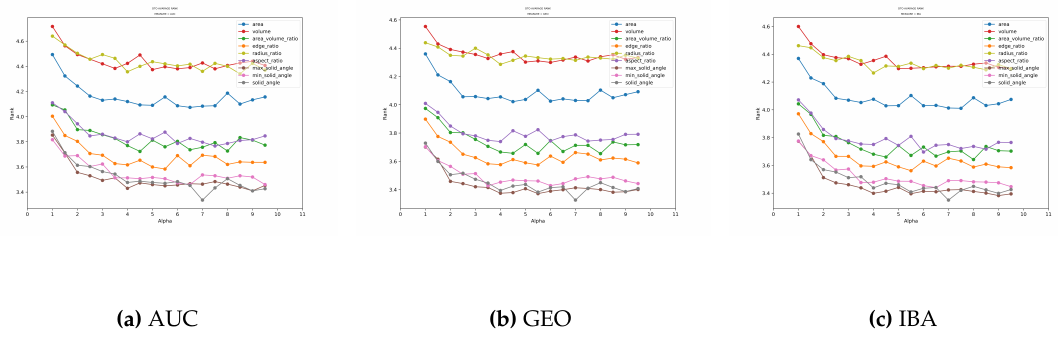
Figure 5. Bi-class DTO-SMOTE rank by Dirichlet alpha